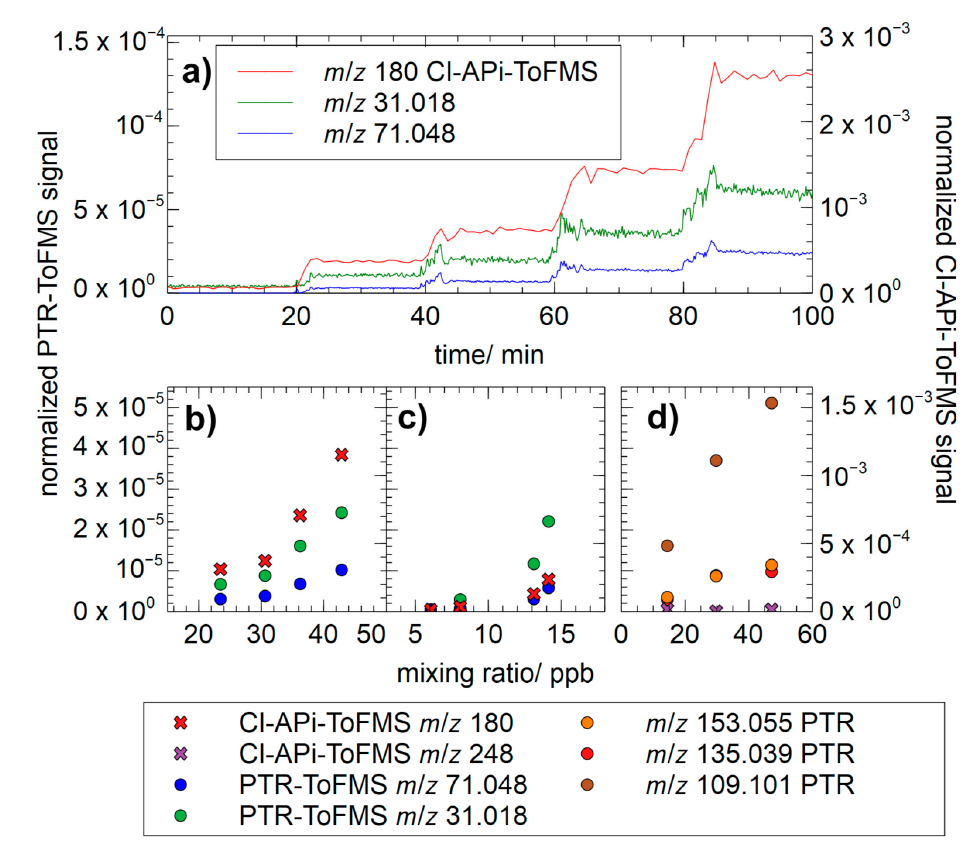
Figure 8. ( a ) Calibration experiment of 1,2-ISOPOOH with stepwise injection of the analytical compound over a gentle gas flow. Panels ( b , c ) show the response-curve of both the corresponding APi-ToFMS peak and PTRMS fragments for 1,2-ISOPOOH ( b ) and 4,3-ISOPOOH ( c ), respectively. Similarly, the response of these instruments for the α -pinene-derived hydroxy hydroperoxide is shown in panel ( d